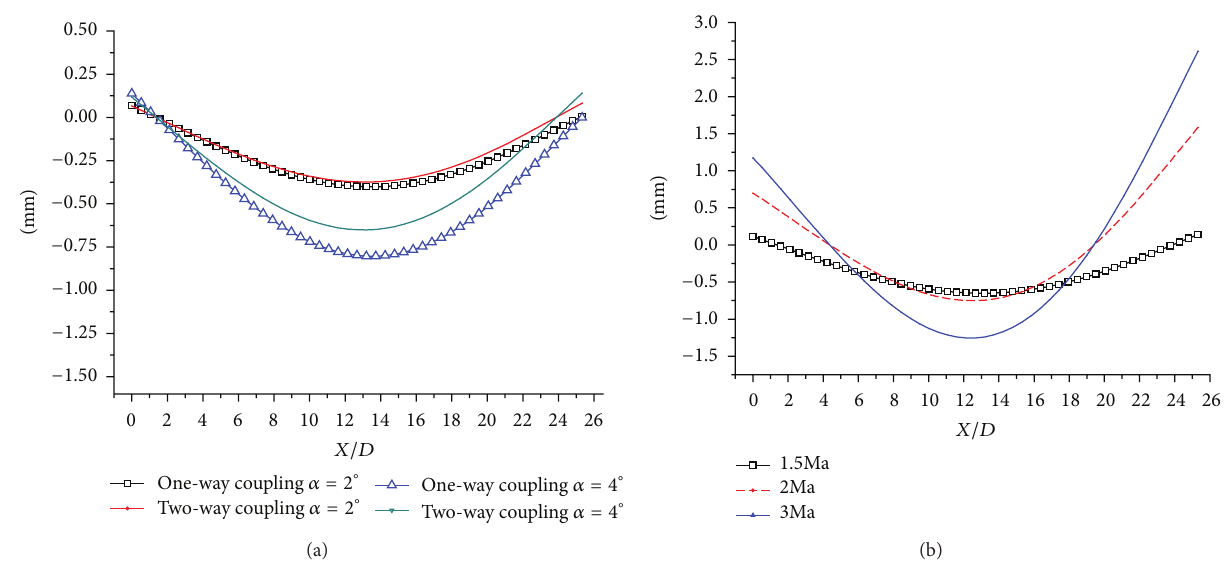
Figure 7: 𝑌 -direction deformation of nonspinning rocket body: (a) 𝑌 -direction deformation of nonspinning rocket body at Ma = 1.5 and (b) 𝑌 -direction deformation of nonspinning rocket body at 𝛼 = 4 ∘ .